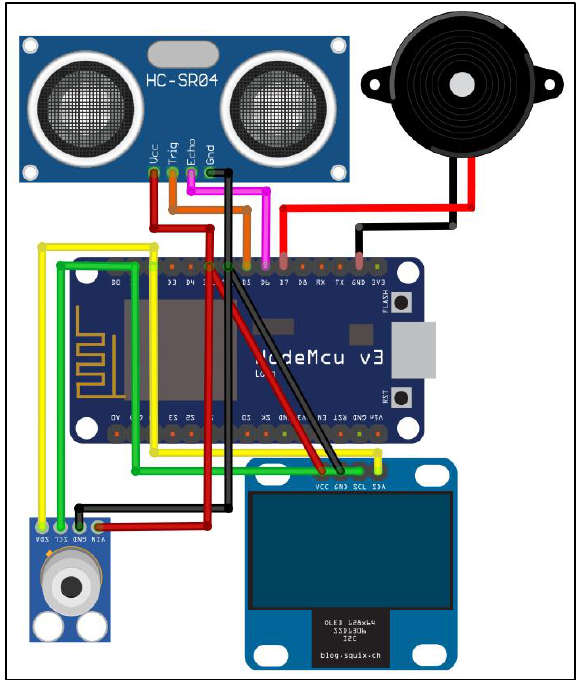
Figure 4. Schematic diagram of the body temperature screening system.